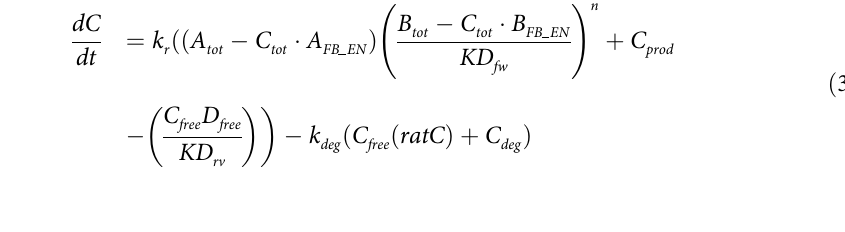
Fig 4. Simplified conceptual block diagram of a reaction unit (see [9, 11] for a detailed circuit–level diagram). The chip has a total of 20 reaction units. Each reaction units block accepts as input total quantities for reactants A and outputs the total amount of product C tot , as well as any remaining “free” reactant A free and B free which has not yet been converted into product. These current–based inputs and outputs are converted into digital signals before being sent outside the chip in order to prevent signal